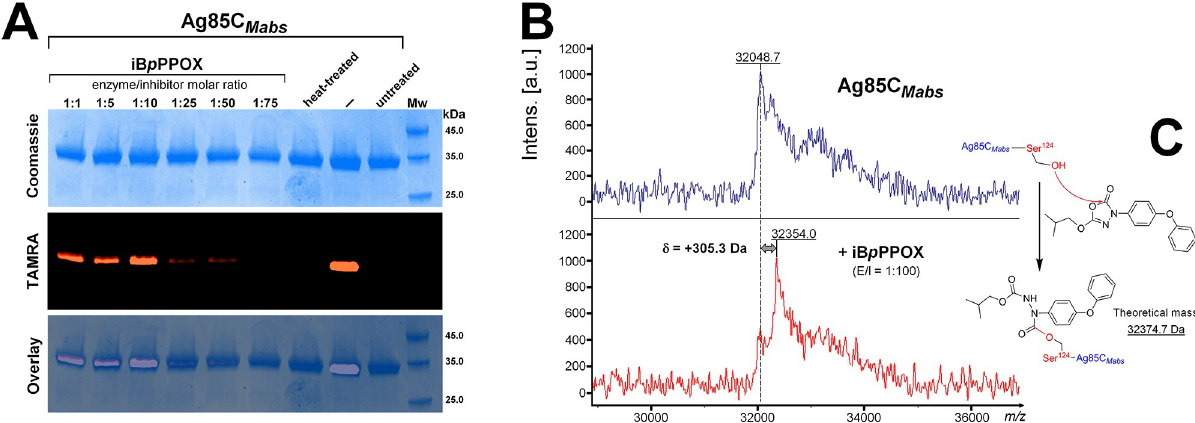
Fig 4. Inhibition of the Ag85C Mabs by iB p PPOX. (A) Ag85C Mabs was pre-treated with iB p PPOX ( i . e . enzyme/inhibitor molar ratio of 1:1 to 1:75), incubated with ActiveX TAMRA-FP, separated by 12% SDS-PAGE, and visualized by Coomassie blue staining ( upper panel ) or in-gel fluorescence visualization ( middle panel ). The merged image is shown in the lower panel . Untreated protein ( i . e ., no TAMRA-FP and no iB p PPOX ) was used as . TAMRA labeling of Ag85C is impaired in the control. No TAMRA-FP labeling is detected in the presence of inactivated heat-treated Ag85C Mabs Mabs Ag85C Mabs - iB p PPOX adducts, as evidenced by the loss of fluorescence in the iB p PPOX lanes, presumably resulting from the covalent binding of iB p PPOX to the catalytic serine as previously observed [24, 25]. TAMRA-labeled Ag85C Mabs was detected by fluorescent gel scanning ( λ ex 557 nm, λ em 583 nm) using the Cy 1 3 filter of a ChemiDoc MP Imager (Bio-Rad) before staining of the gel with Coomassie Brilliant Blue dye. Relative fluorescence quantification of each band was performed using the ImageLab ™ software version 5.0 (Bio-Rad) by taking as 100% absolute fluorescence level the labeled Ag85C -TAMRA adduct. (B) Global mass modification of Ag85C pre-incubated with iB p PPOX , at an enzyme/inhibitor molar ratio of Mabs Mabs 1:100 to ensure total inhibition, as determined using an MALDI-TOF-TOF mass spectrometer in linear mode. (C) Mechanism of inhibition of Ag85C by the oxadiazolone iB p PPOX , based on mass spectrometry analysis. a.u., arbitrary Mabs